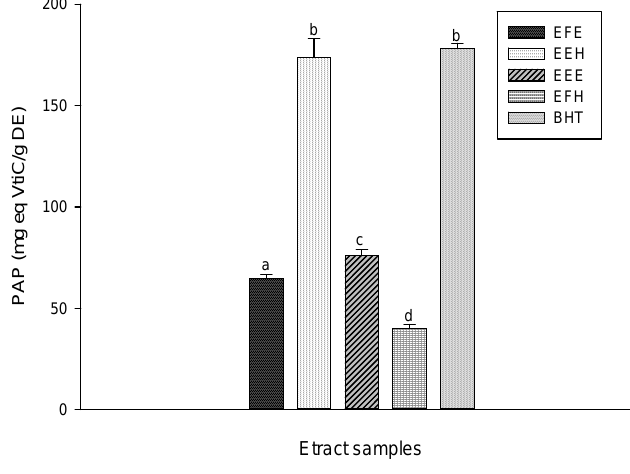
Table 1. Total phenol, flavonoid, and flavonol contents of the different plant extracts.